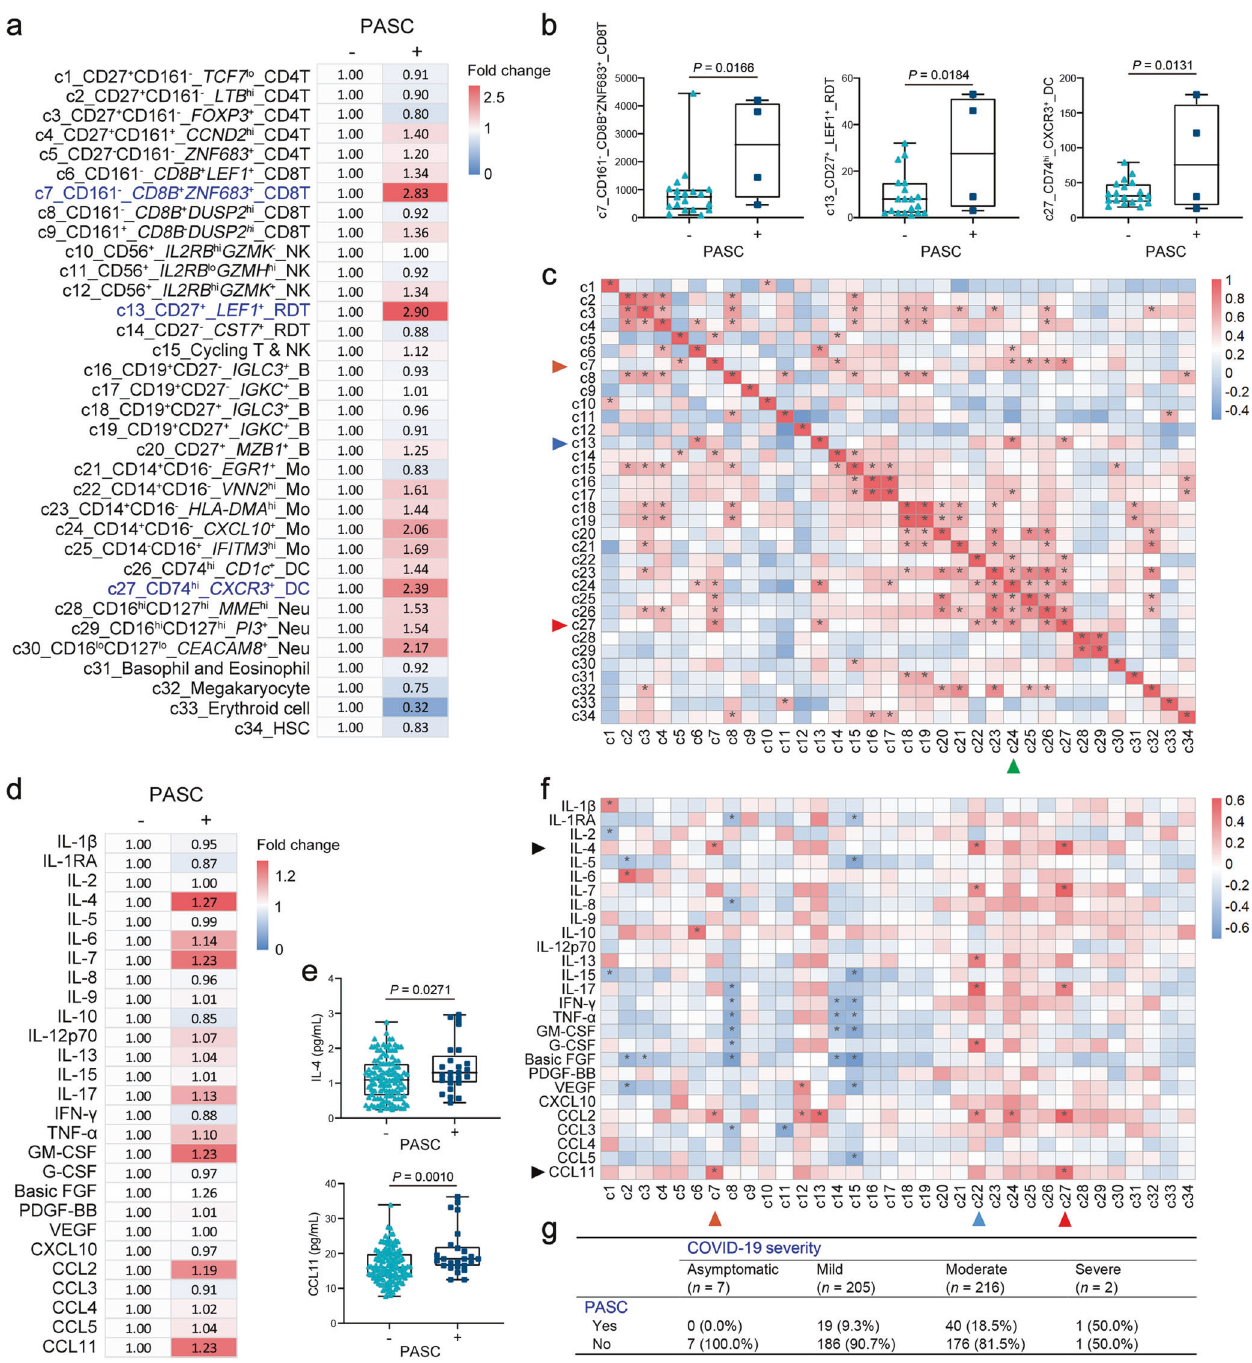
Fig. 6 Association of post-acute sequelae of COVID-19 (PASC) and IFN-responsive immune cells and cytokines/chemokines. a The fold change of the cell number in each cluster between Omicron convalescents with PASC ( n = 4) or without PASC ( n = 19). b Box plots showing the differences in cell number between Omicron convalescents with or without PASC. t -test. c Heatmap showing correlations across each cluster in Omicron convalescents. Spearman rank correlation test. d The fold change of plasma concentrations of cytokines and chemokines between Omicron convalescents with PASC ( n = 25) or without PASC ( n = 118). e Box plots showing the differences in plasma concentrations of cytokines and chemokines between Omicron convalescents with or without PASC. t -test. f Heatmap showing correlations across cytokines/ chemokines and cell clusters in Omicron convalescents. Spearman rank correlation test. g The correlation between PASC and acute COVID-19 severity in all infected individuals of the Omicron epidemic in Tianjin during January – February 2022 ( n =